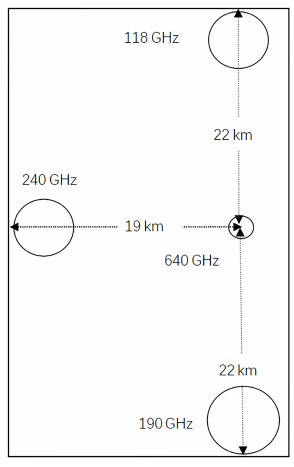
Figure 2. The layout of the four antenna feeds. The observation displacements of the four radiometers are